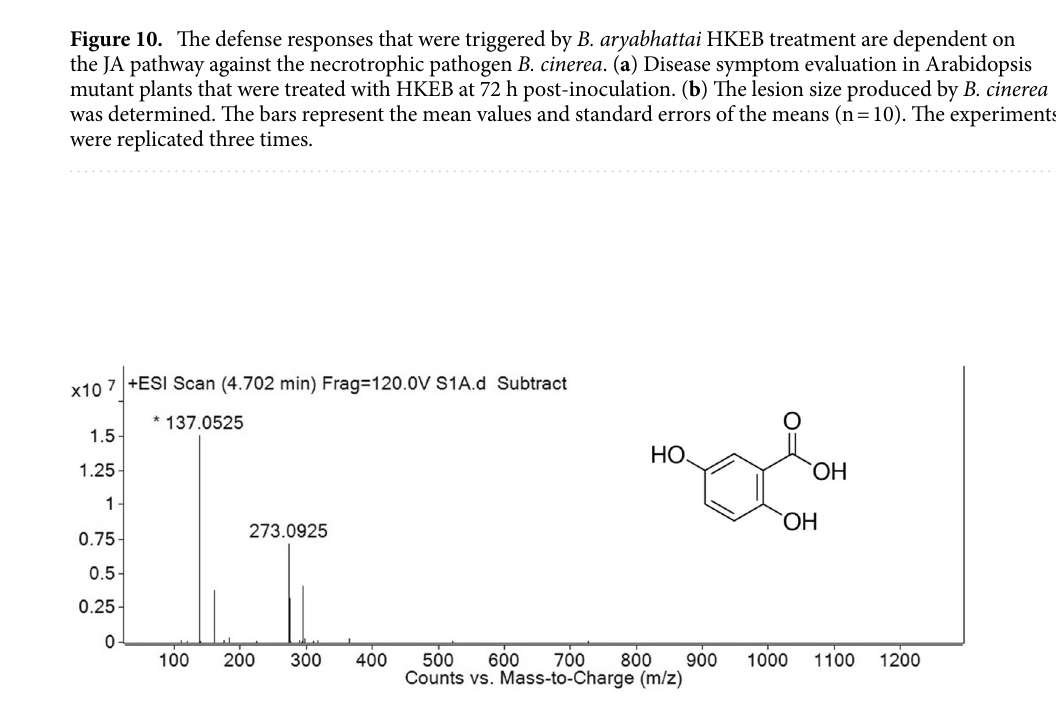
Figure 11. HPLC–MS spectrum of gentisic acid found in B. aryabhattai